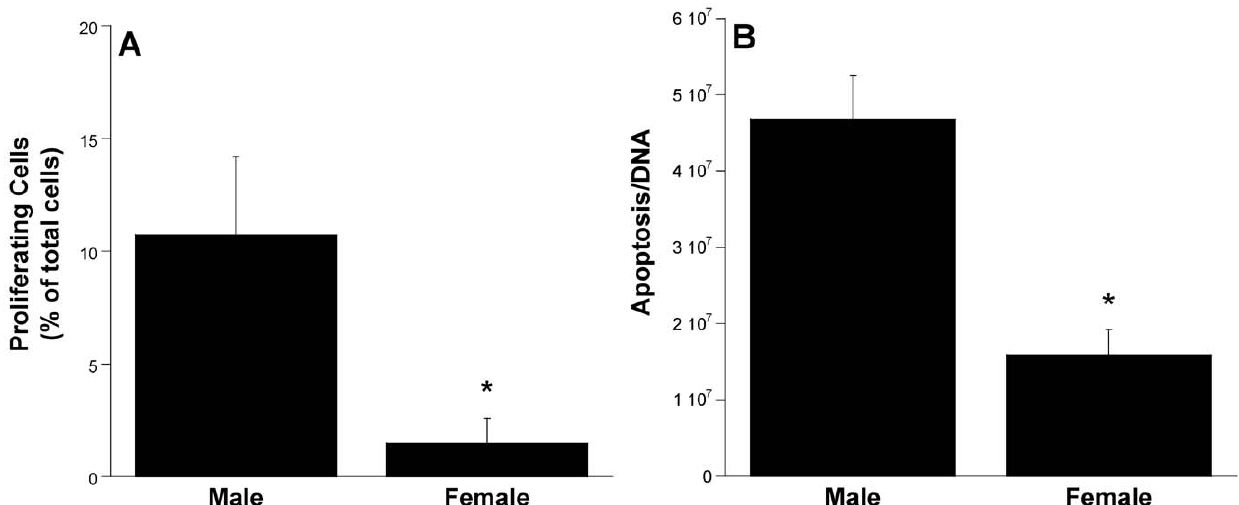
Figure 6. Translation of findings to invitro VIC function. Male and female VICs were cultured for 5 days in serum-free media and evaluated for (A) proliferation, using the Click-iT EdU Alexa Fluor 488 Imaging Assay, and (B) apoptosis, using the Promega Caspase-Glo 3/7 Assay System. Values are means plus standard deviation, n=4 per condition. *P , 0.05 compared to male VICs.